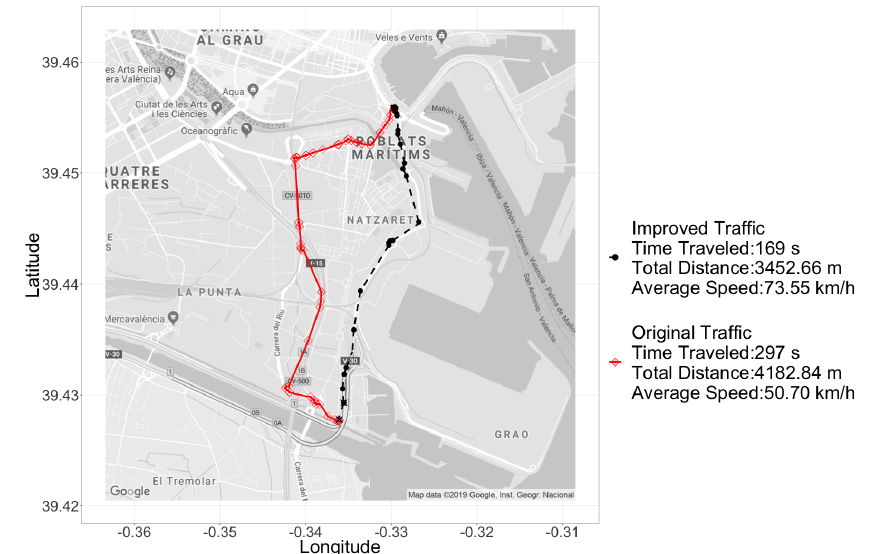
Figure 4. Long routes examples of the city of Valencia.